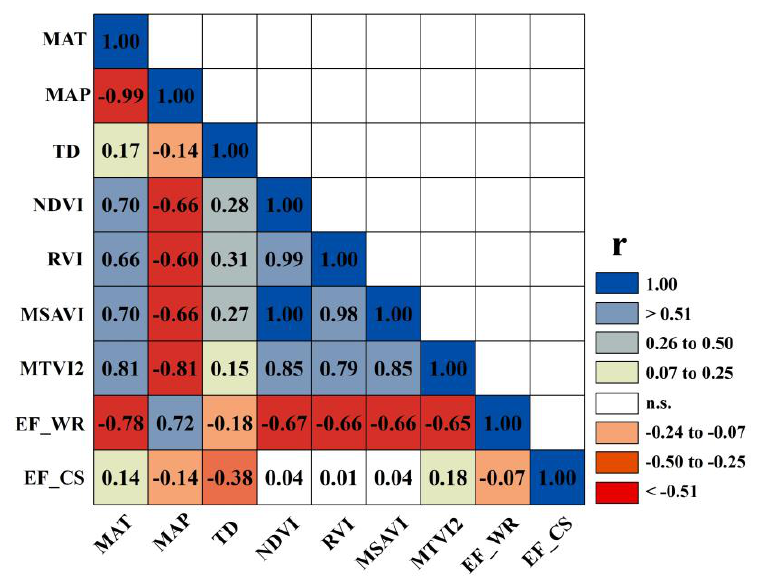
Figure 5. A heat map of the correlations among the variables. Colors indicate the strength of the correlation, where dark blue and dark red indicates a perfect correlation (ns, is not significant). The variables are the mean annual temperature (MAT), mean annual precipitation (MAP), tourist disturbance (TD), normalized di ff erence vegetation index (NDVI), ratio vegetation index (RVI), modified soil-adjusted vegetation index (MSAVI), modified triangular vegetation index-improve (MTVI2), water retention (EF_WR), and carbon sequestration